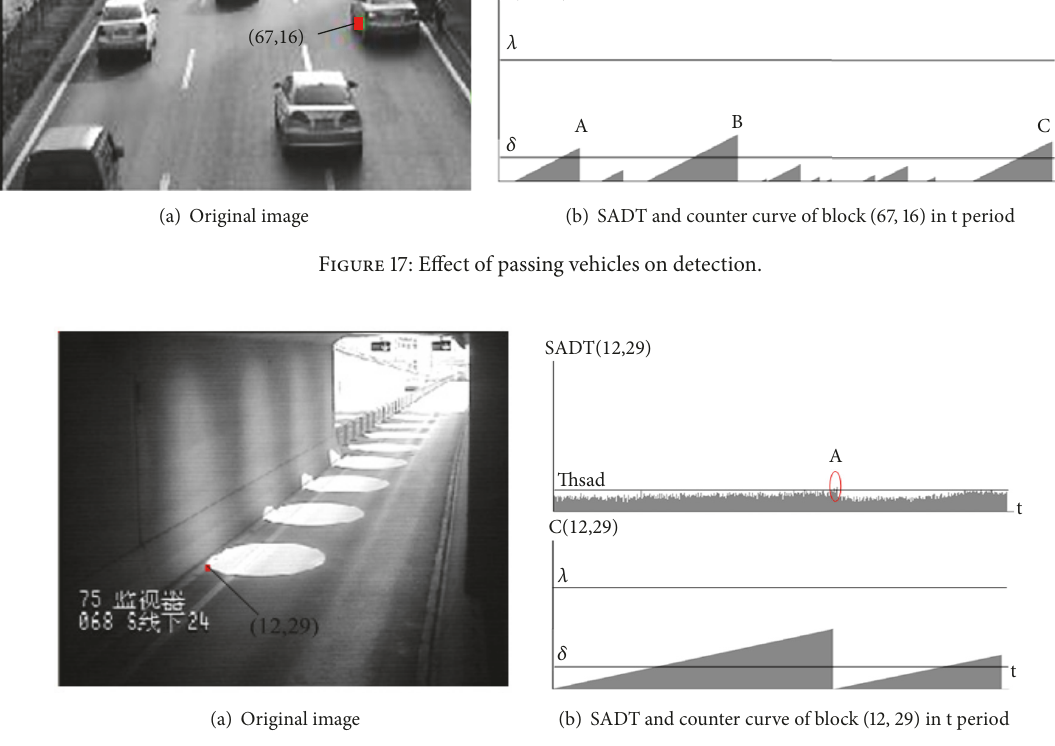
Figure 18: Effect of illumination on